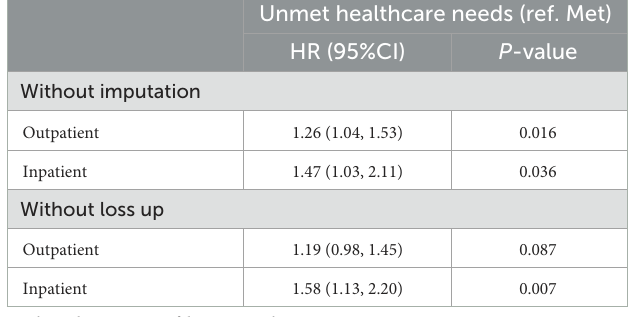
TABLE 3 Association between UHN and frailty based on Cox regression with time-varying exposure.